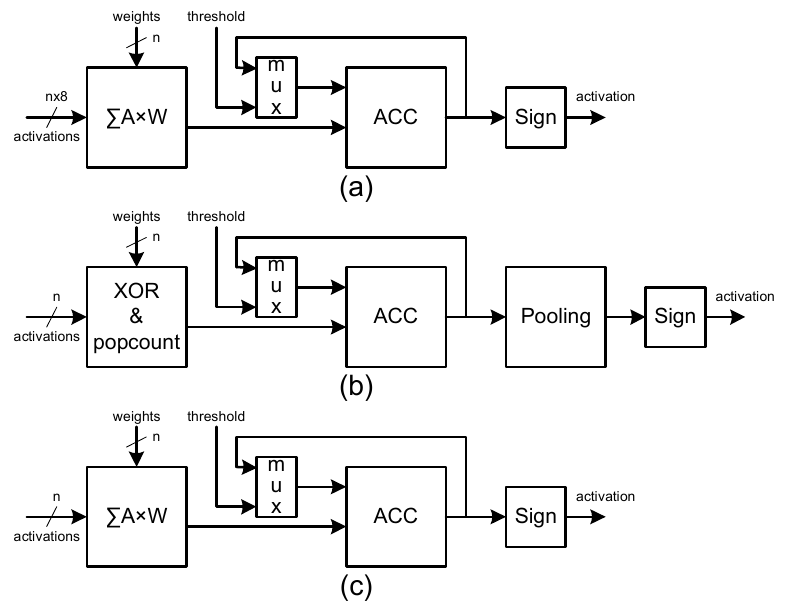
Figure 5. Architecture of cores. ( a ) Core of the module for the first layer; ( b ) core of the module for the hidden layer; ( c ) core of the module for the last